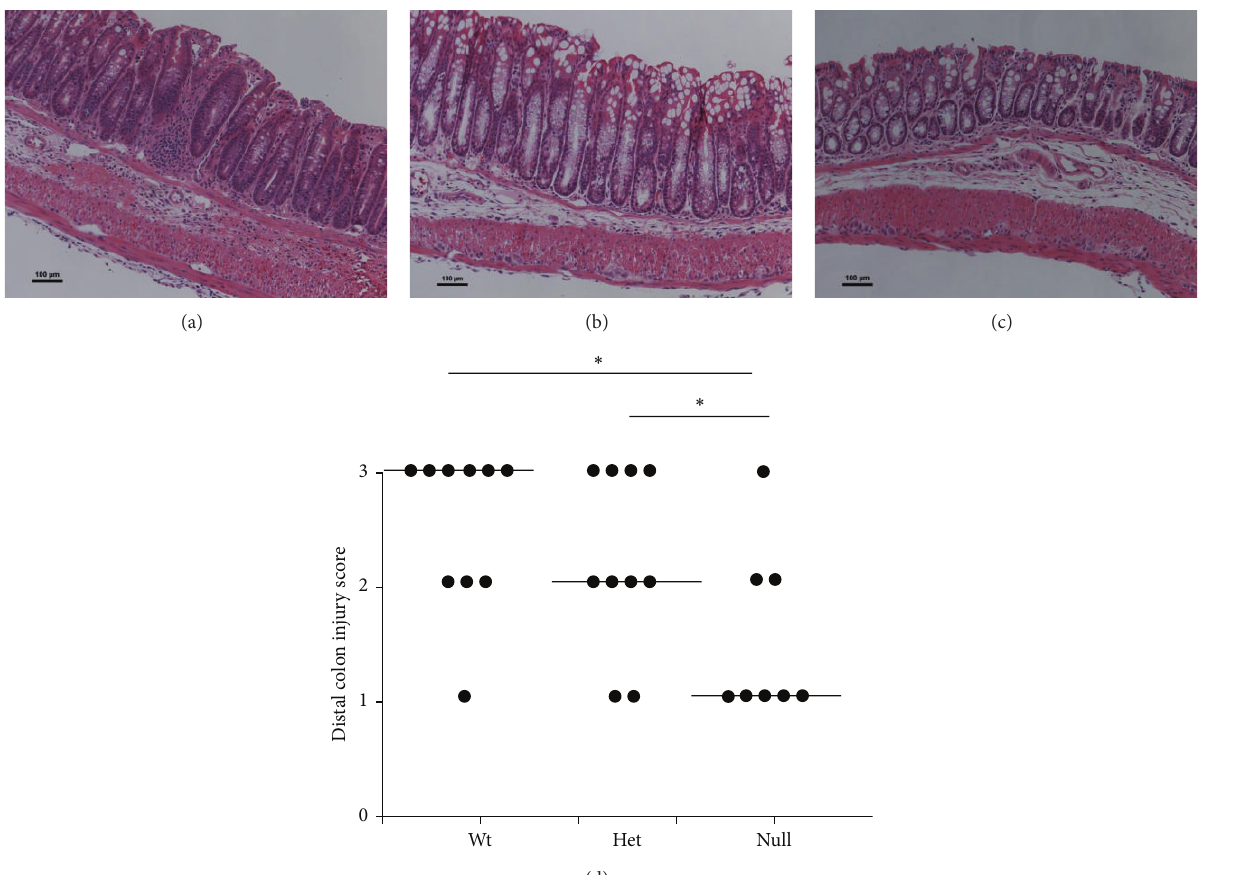
Figure 5: Distal colon histological injury/damage scores assessed in Wt, Het, and Null Fads1 TNBS-treated mice ( 𝑛 = 8 –10/genotype) in a blinded manner by a board-certified pathologist (B. Weeks). ((a)–(c)) Representative images (100x magnification, scale bar = 100 𝜇 m) of Wt, Het, and Null Fads1 TNBS-treated distal colons, respectively. (d) Distal colon injury scores (0–3). Data were analyzed using the Kruskal-Wallis test ( 𝑃 ≤ 0.05 ) followed by Wilcoxon two-sample testing. Median values are shown and significant differences between genotypes are marked by an asterisk ( 𝑃 ≤ 0.05